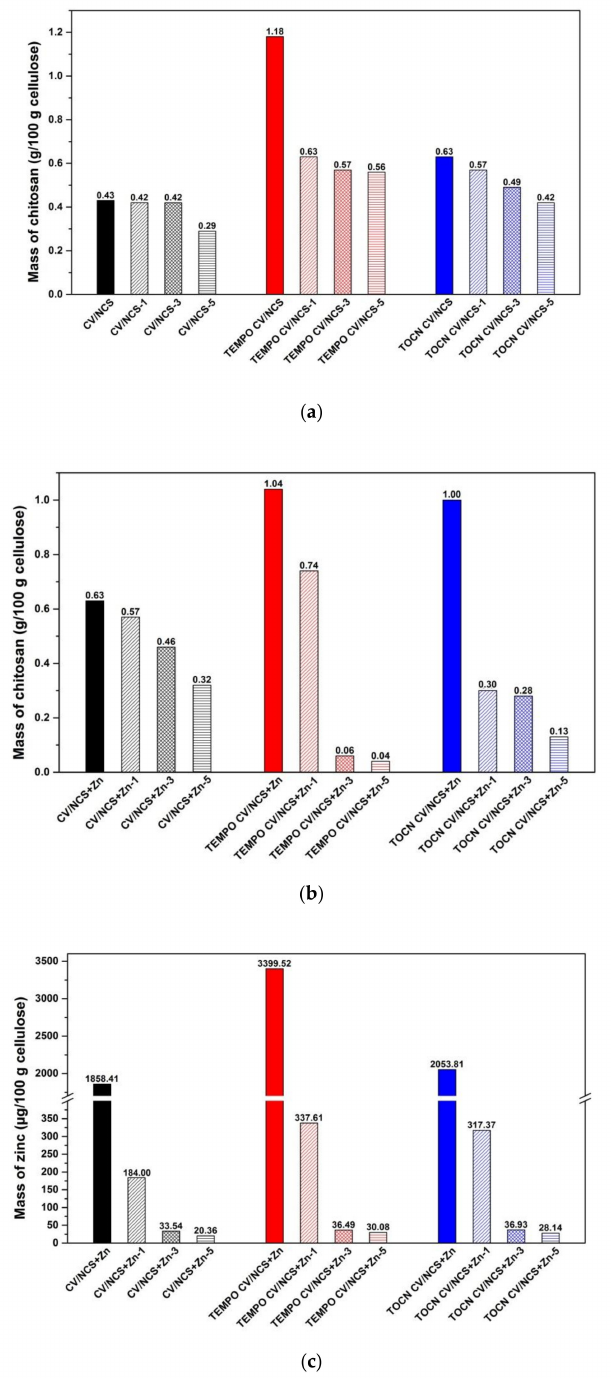
Figure 6. The chitosan ( a , b ) and zinc ( c ) content in the NCS and NCS + Zn functionalized viscose fabrics after 1, 3 and 5 washing cycles; modified from